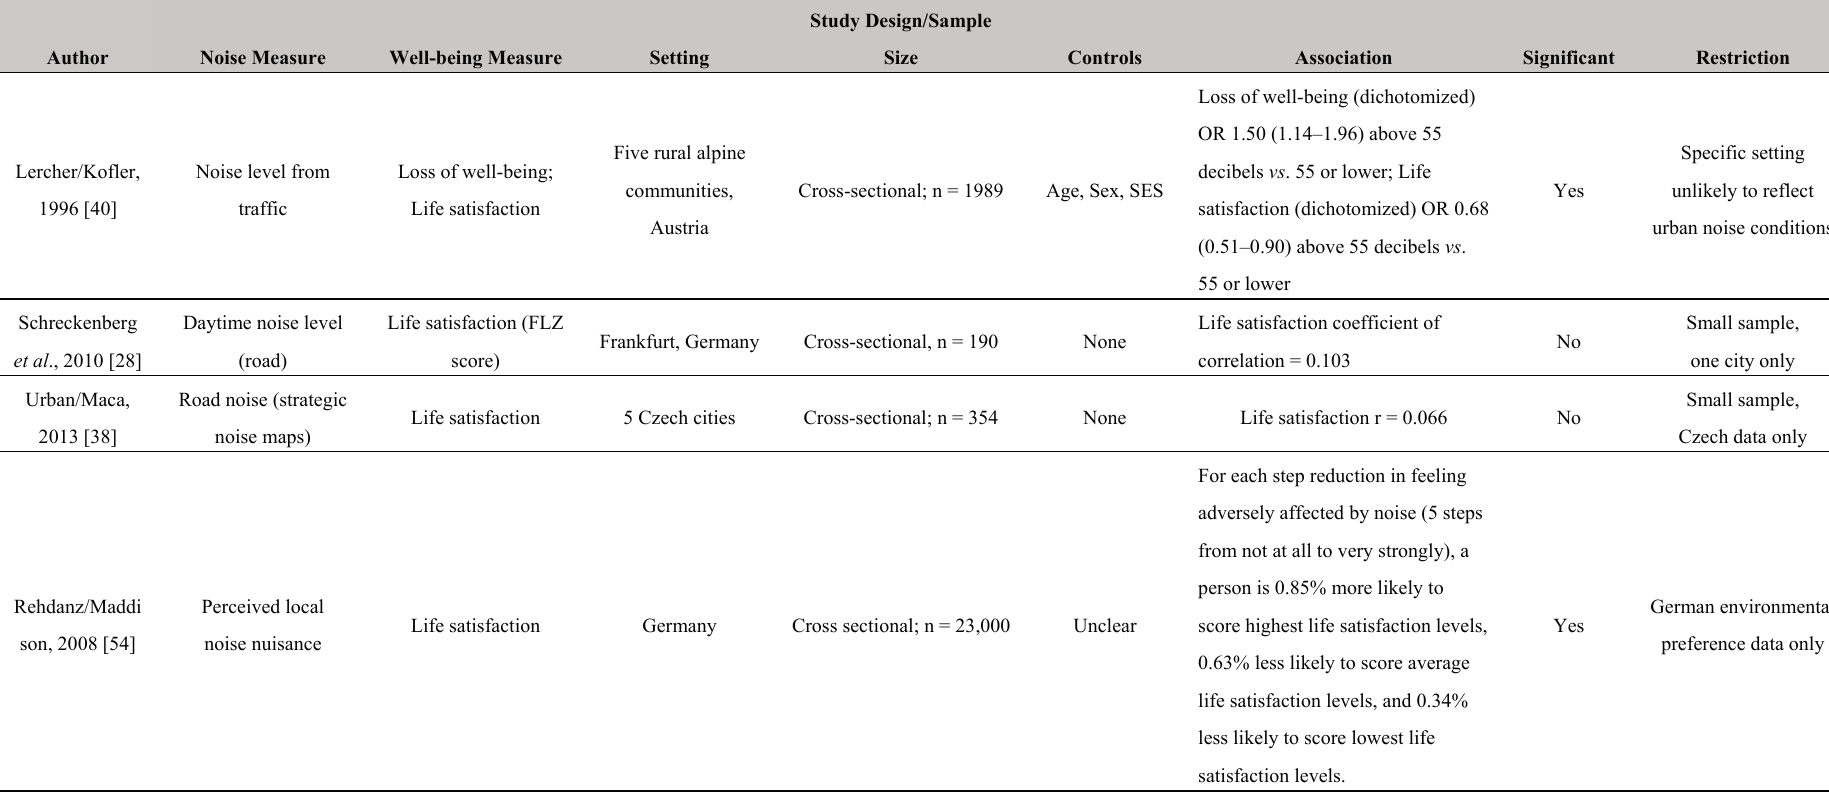
Table 2. Papers presenting quantitative associations between noise and well-being